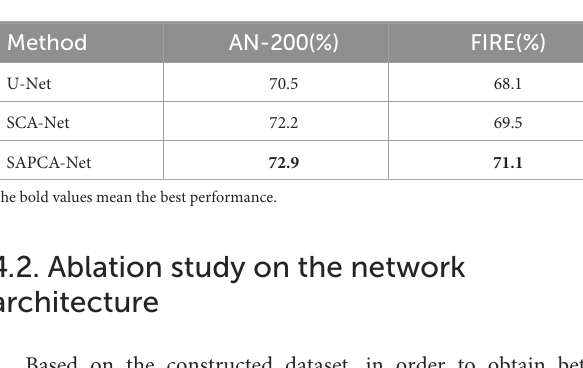
As a result, the final fused result with the matching keypoints generated by the SAPCA-Net is visually better than other